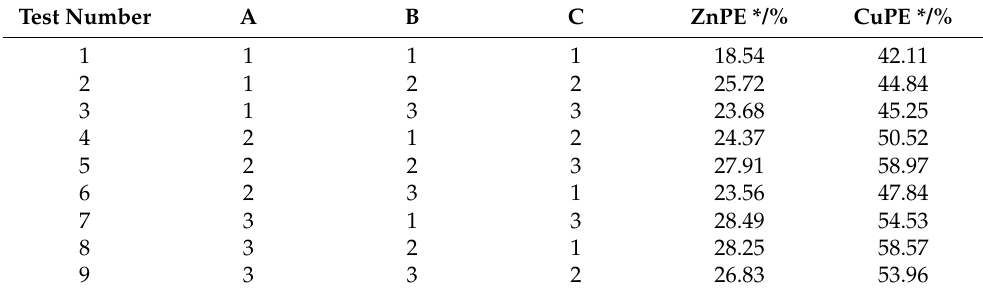
Table 6. Passivation effect of Zn and Cu in biogas residues from pig manure anaerobic digestion.